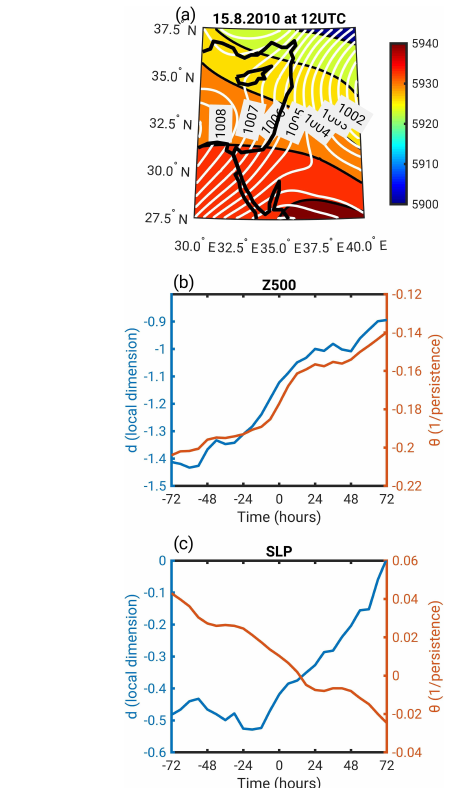
Figure 6. A dynamical systems analysis for the mid-August 2010 heat wave. (a) SLP (white contours, in hPa) and Z 500 (shading, in m) on 15 August 2010 at 12:00UTC. The dynamical systems metrics’ ( d and θ ) temporal evolution centered on 15 August 2010 at 12:00UTC (0h) computed on (b) Z 500 and (c)